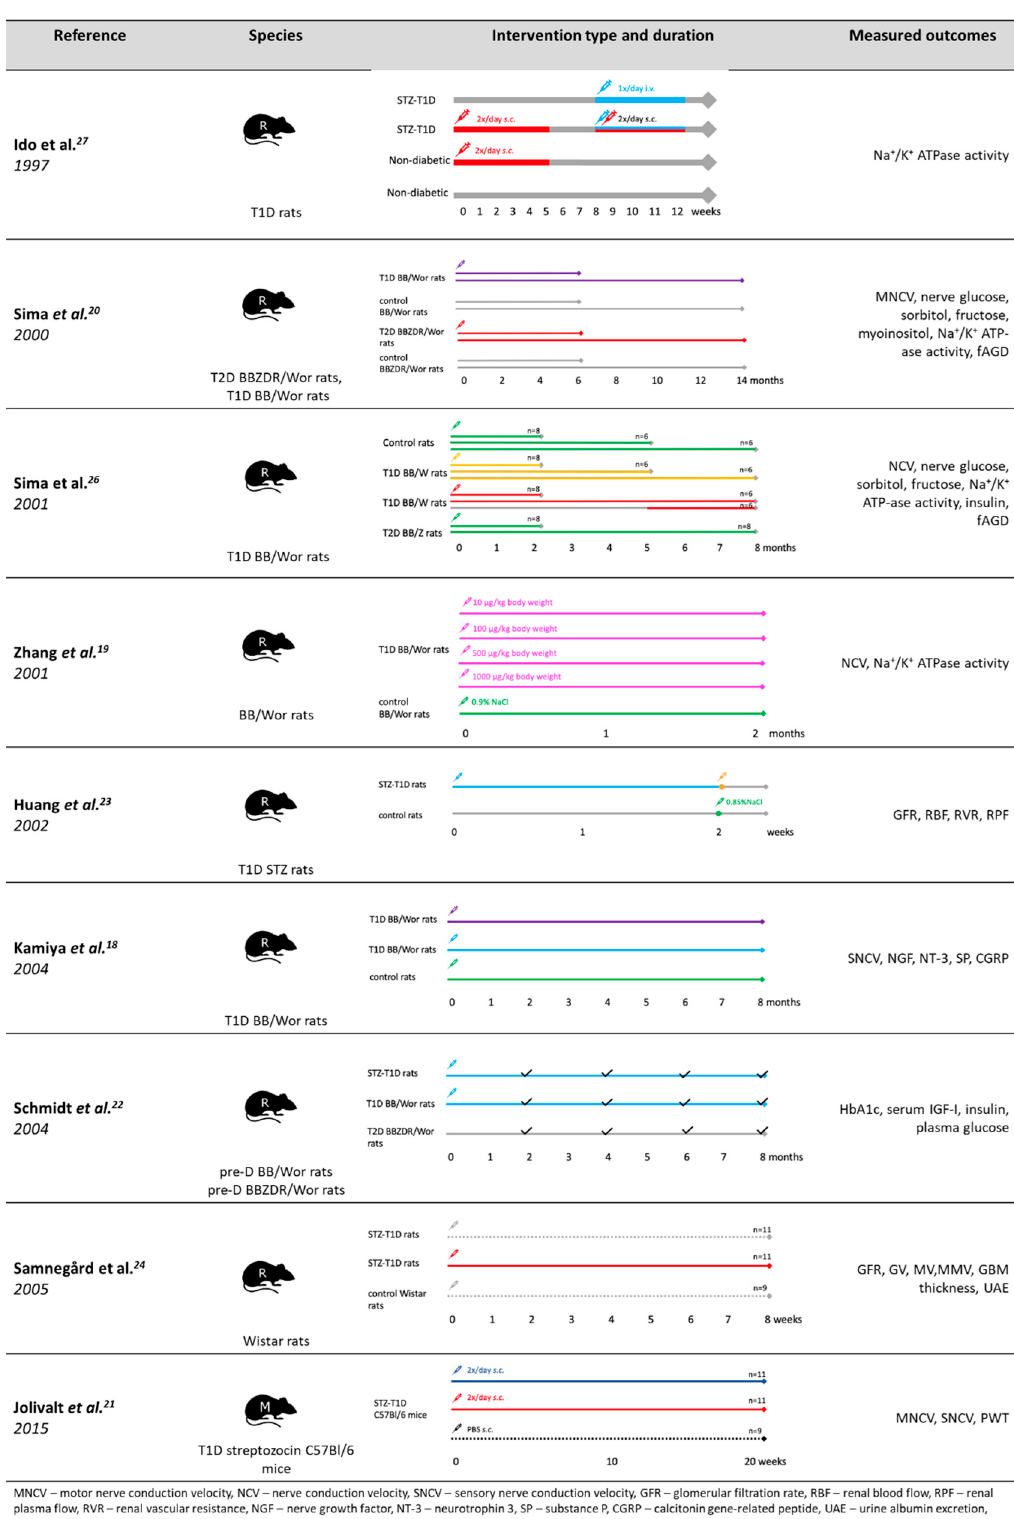
Figure 4. Study design of animal studies reviewed in this paper.